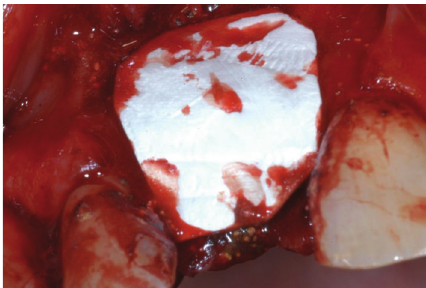
Figure 7: An absorbable collagen membrane was placed over the graft, covering all the defect and adjacent bone borders.